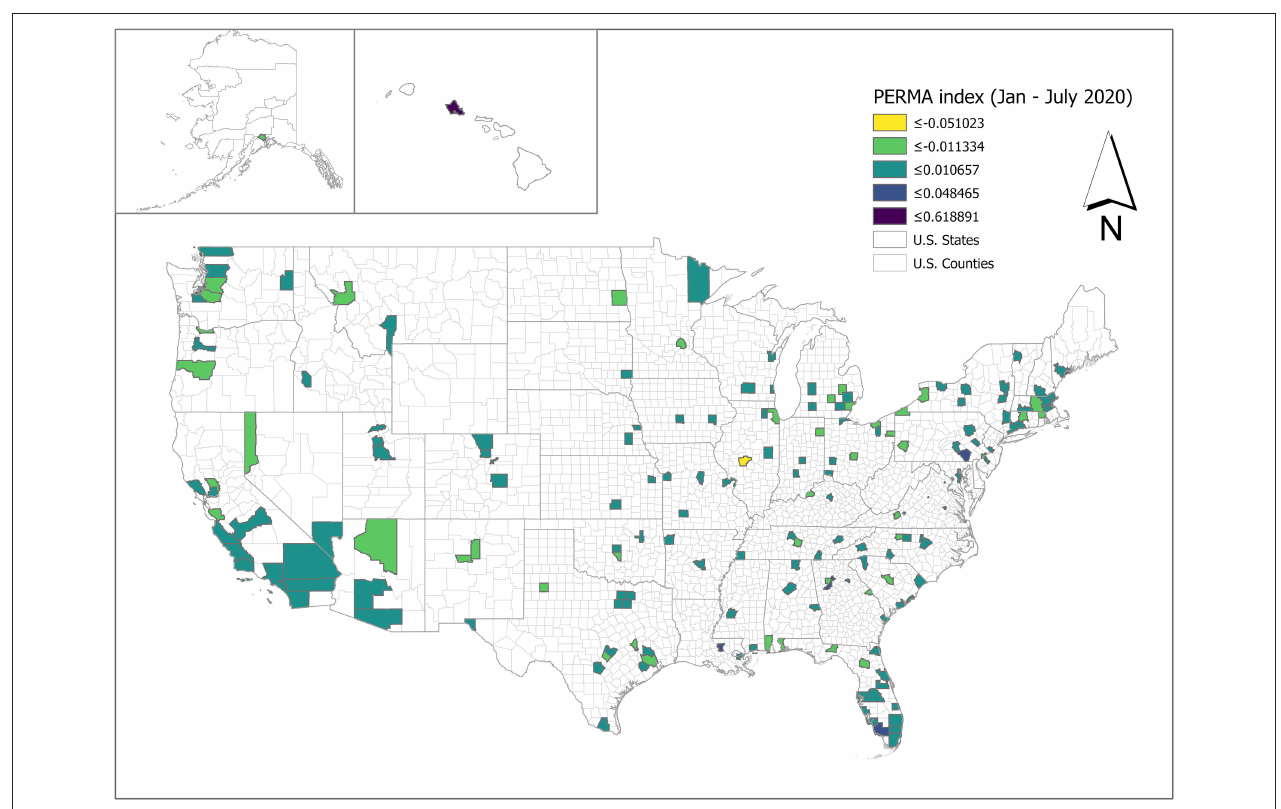
FIGURE 1 | Overall PERMA index for counties with n ≥ 300 tweets (January to July